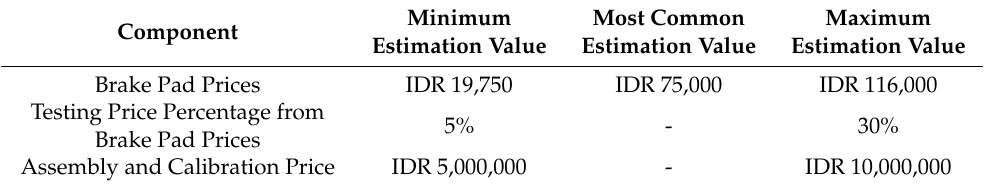
Table 10. Extra Cost Detail of BEP and Payback Period on Monte Carlo Simulation.